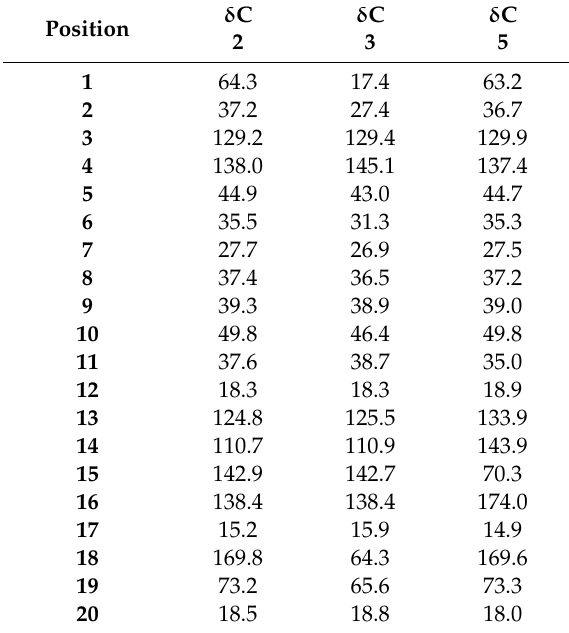
Table 2. 13 C-NMR spectroscopy data of 2 , 3 and 5 (CDCl 3 , 150 MHz).